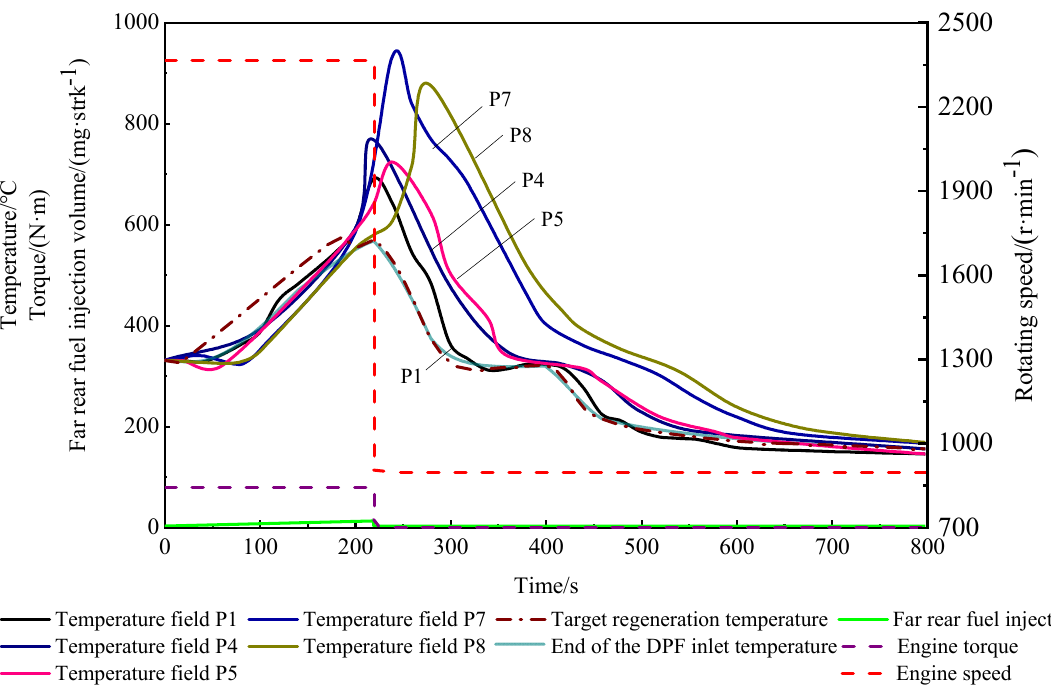
Figure 10. DTI testing results of test point E.